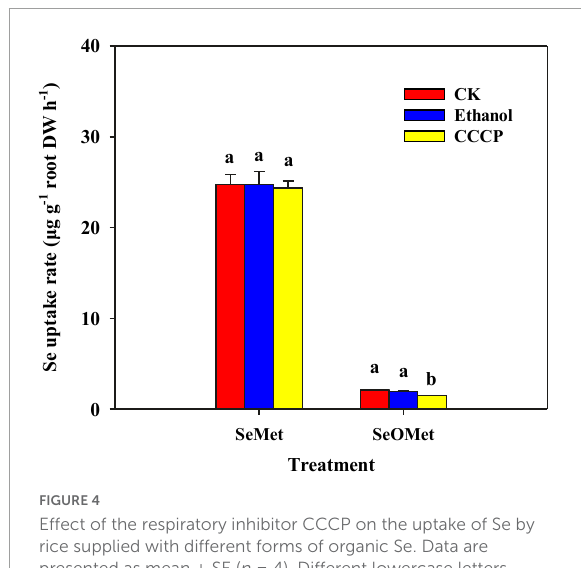
FIGURE4 Effect of the respiratory inhibitor CCCP on the uptake of Se by rice supplied with different forms of organic Se. Data are presented as mean + SE ( n = 4). Different lowercase letters above bars indicate significant differences among inhibitor treatments in individual Se treatment forms ( P <